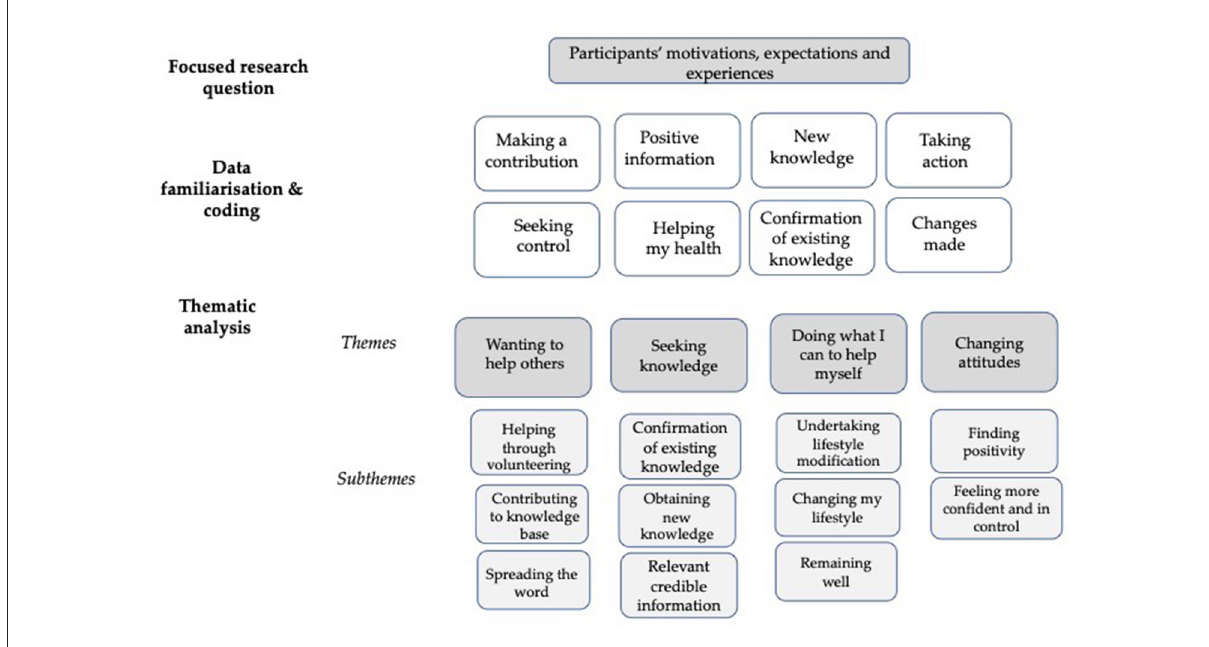
FIGURE2 Diagrammatic representation of thematic